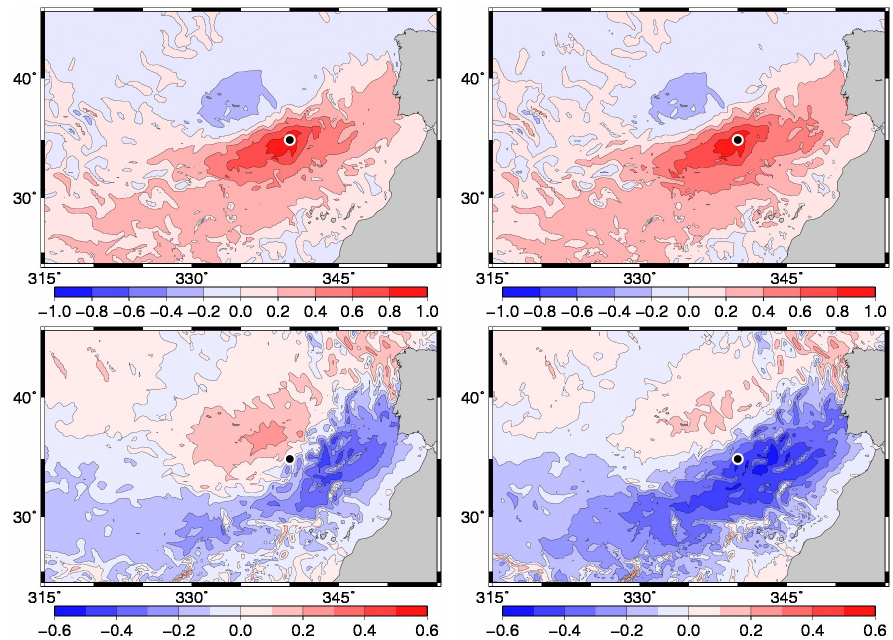
Fig. 8. Phytoplankton (top panels) and nitrate (bottom panels) horizontal correlation structure with respect to phytoplankton at 20 ◦ W 35 ◦ N (North Atlantic), without anamorphosis (left panels), and after local anamorphosis transformations (right panels).